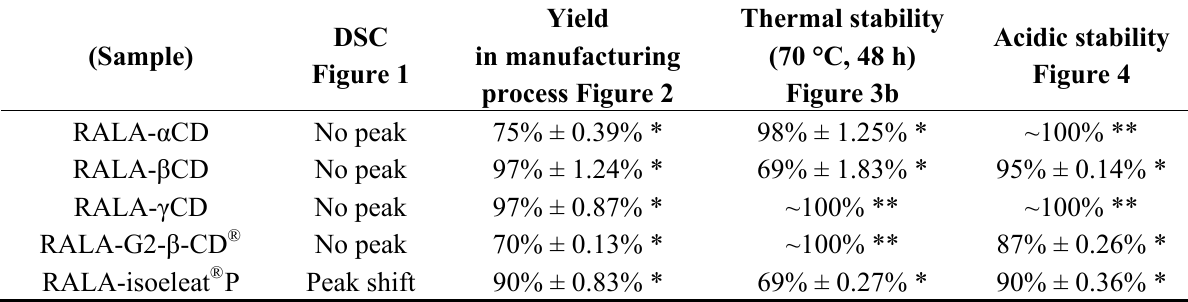
Table 1. Summarized stability test results of the analyzed RALA-CD complexes.